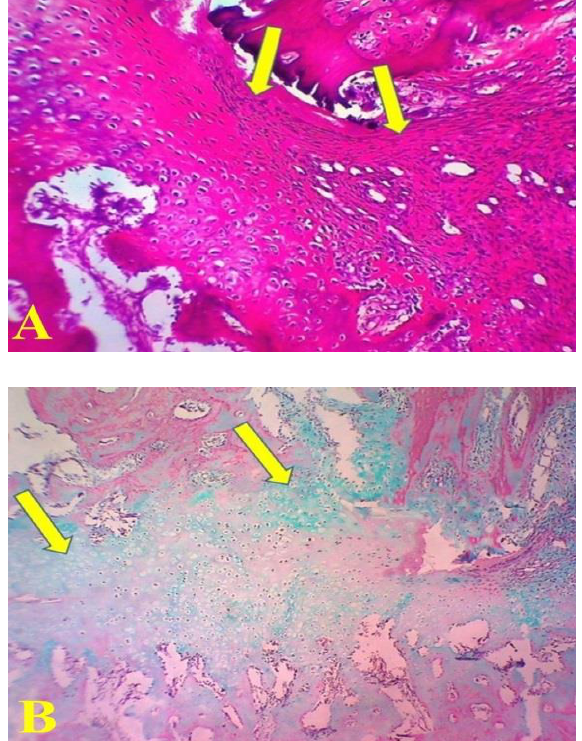
Figure, 2: In the second group at the sixth week, shown increase of proliferation and density of fibrous tissue, as well as fibrocartilaginous tissue in the fractured bone gap (yellow arrow). A: H&E X40, B: Masson Trichrom